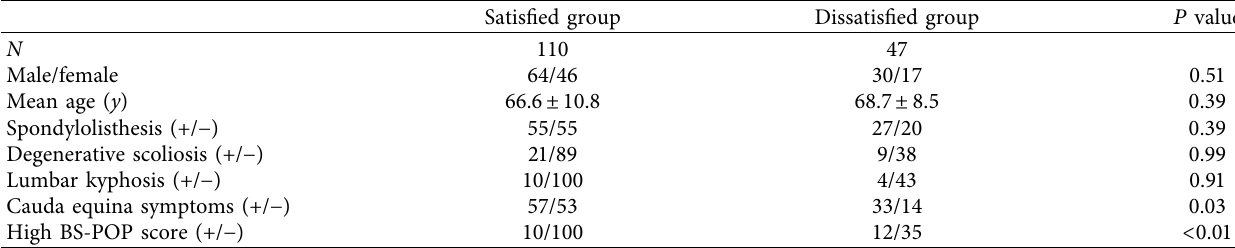
Table 3: Preoperative status and satisfaction at 1 year after surgery.